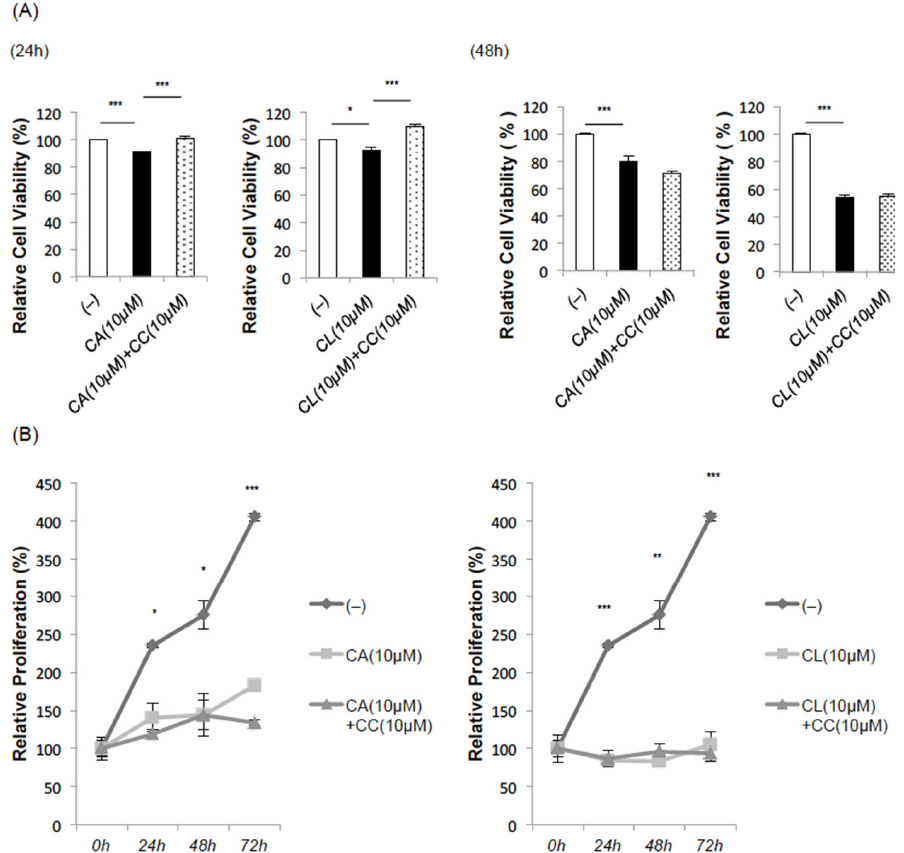
Figure 5. CA and CL inhibit proliferation of HepG2 hepatoma cells. ( A ) MTT assay. After pretreat- ment with CC (10 µ M) for 1 h, HepG2 cells were treated with CA (10 µ M) or CL (10 µ M) for 24 h (left panel) and 48 h (right panel), and then subjected to MTT assay. ( B ) Cell proliferation assay. (*: p < 0.05, **: p < 0.01. ***: p < 0.001).